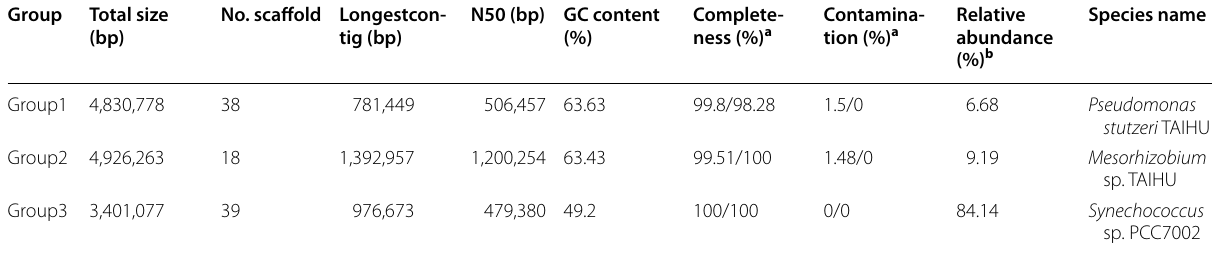
a The completeness and contaimnation were determined by the CheckM software, the first value before the slash was the result of lineage-specific workfow and the latter one was the result of taxonomy-specific workflow in the program b The relative abundance was the proportion of reads on each genome bin in the total merged read, excluding paired read and the alignment was performed by the BWA software